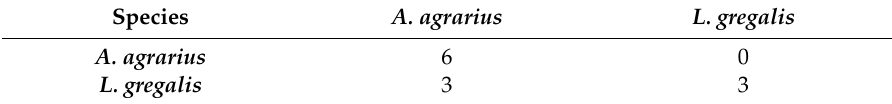
Table 5. 2 × 2 matrix sample obtained when comparing two species (a concrete example).